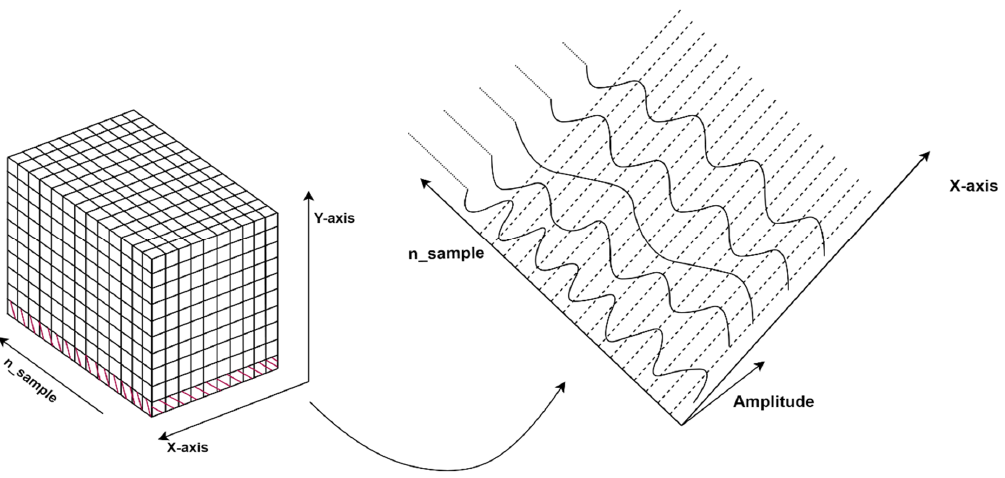
Figure 5. Radar three-dimensional data block and the schematic diagram of extracting two-dimensional data block under a fixed Y-direction displacement.